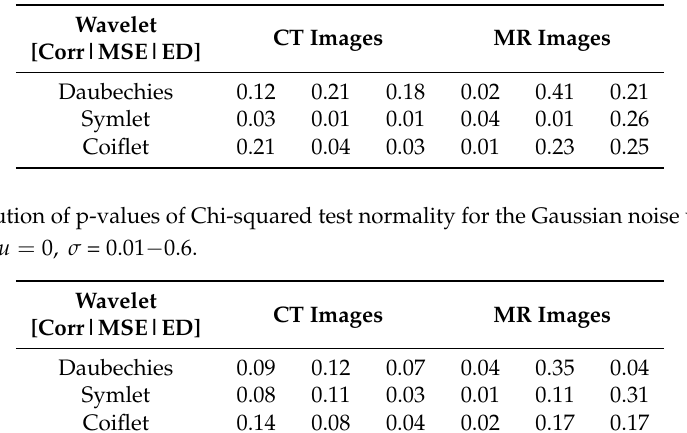
Table 1. Distribution of p-values of Chi-squared test normality for the Salt and Pepper noise with dynamical noise intensity: d = 0.001 − 0.65.